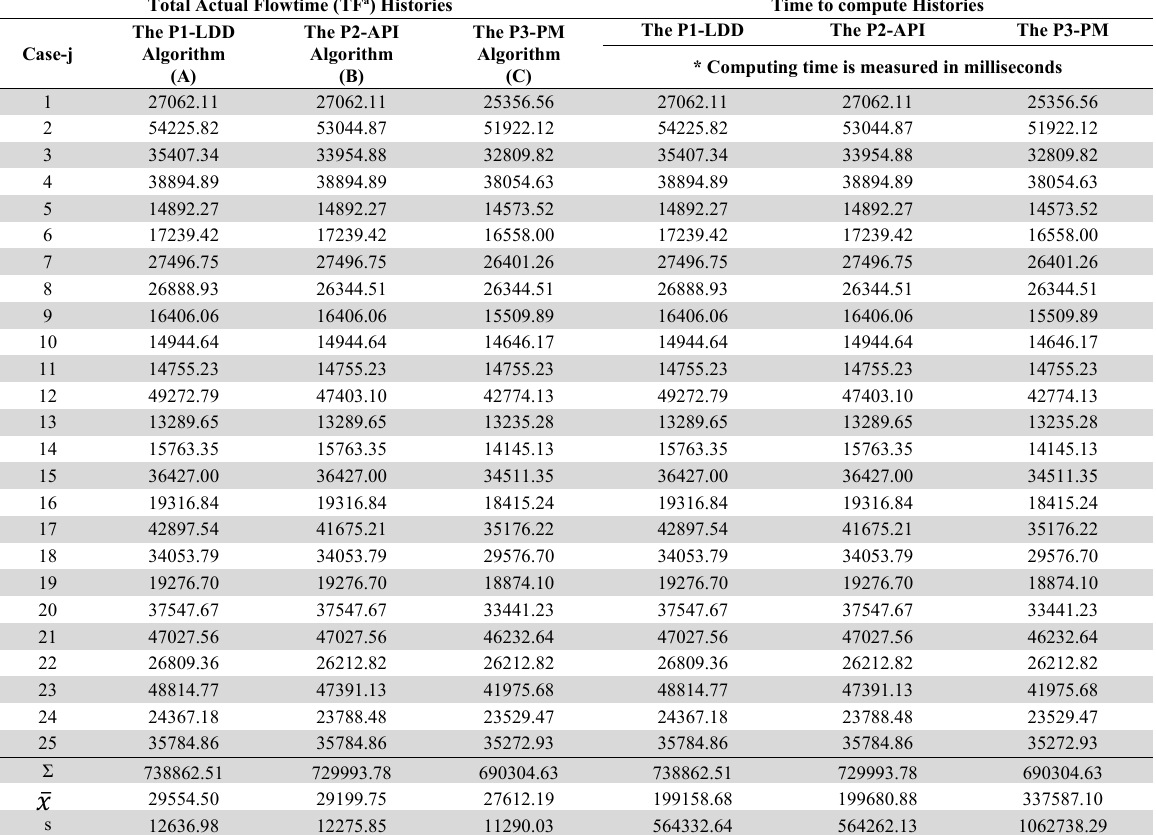
The result of the numerical experience